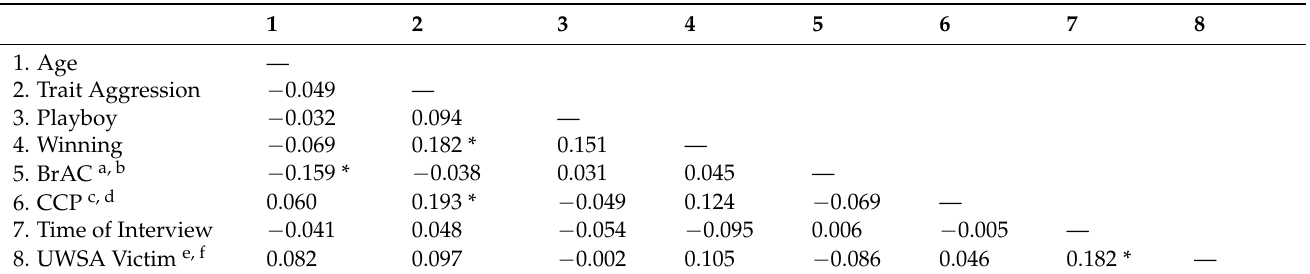
Table A3. Pearson and Point-Biserial Correlations for Males between Age, Trait Aggression, Play- boy, Winning, Breath Alcohol Content, Childhood Corporal Punishment, Time of Interview and UWSA Victimisation.